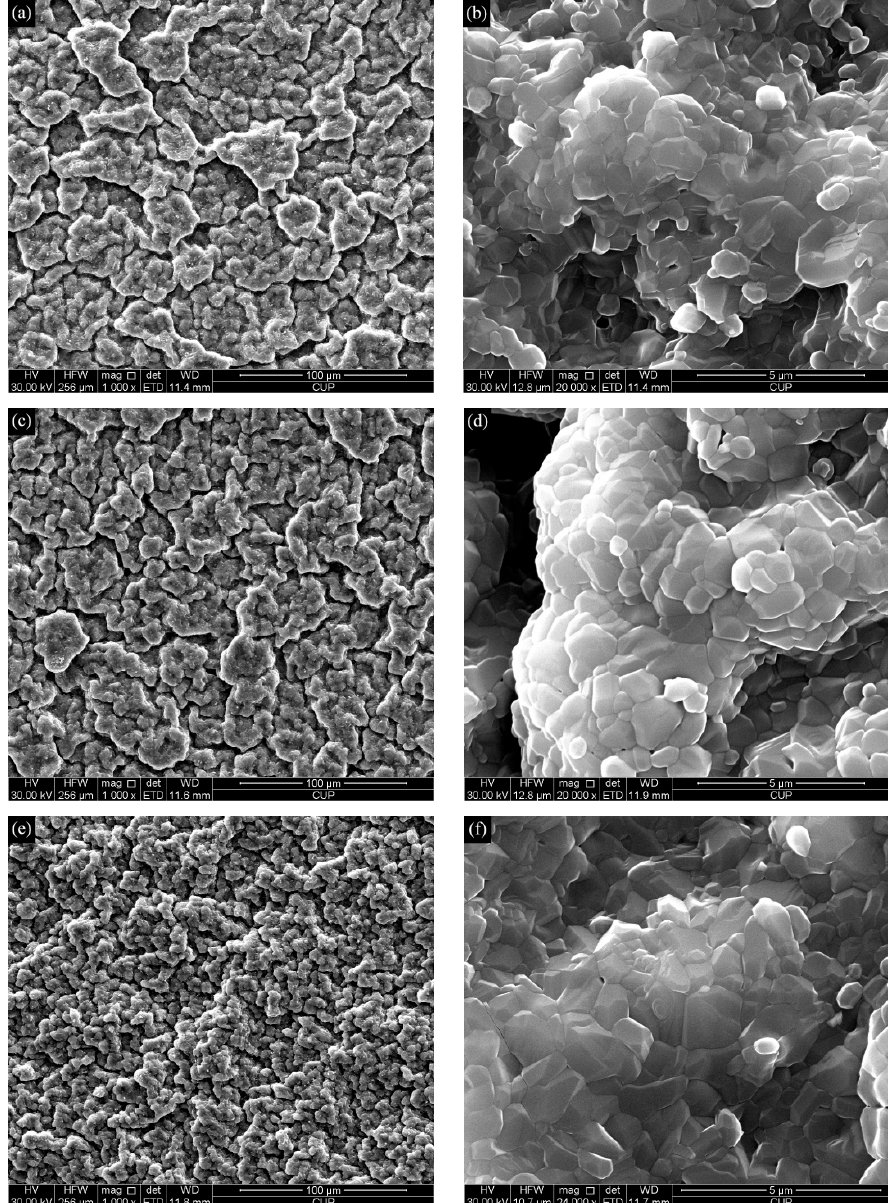
Figure 7. The surface morphologies of the oxide scales after 100 h cyclic oxidation at 1150 °C: ( a , b ) NiAl–Hf, ( c , d ) NiAl–Zr, ( e , f ) NiAl–Hf–Zr. ( a , b ) NiAl–Hf, ( c , d ) NiAl–Zr, ( e , f )